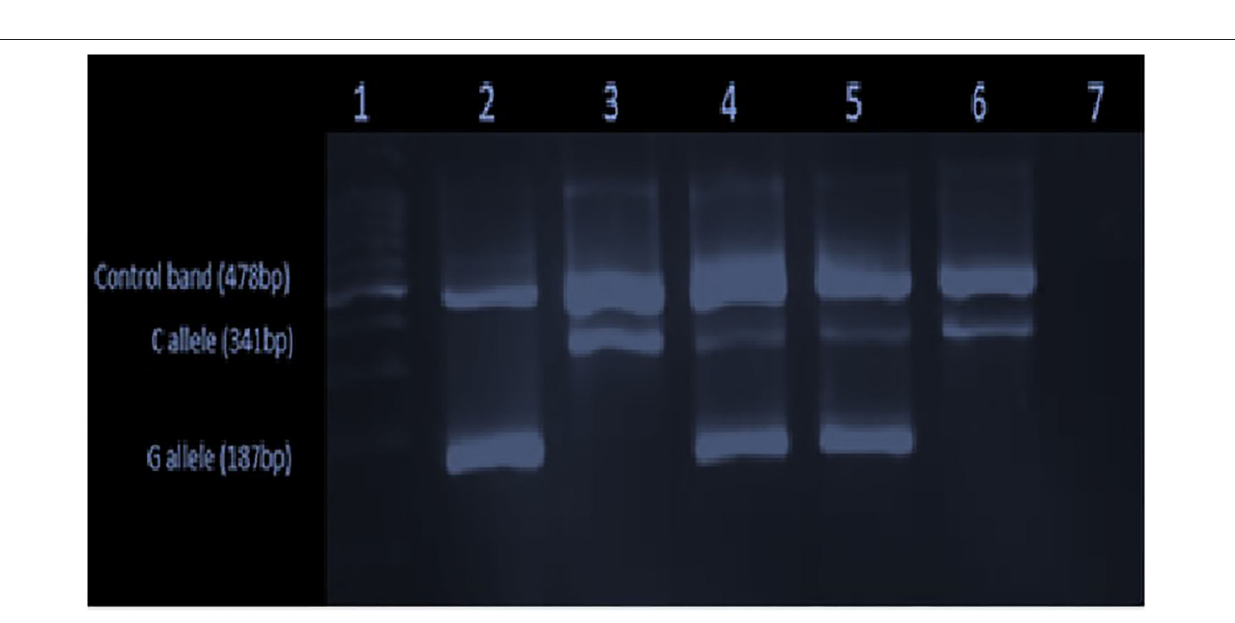
FIGURE 2 | Gel image showing the p.H63D [c.187C > G] mutation: 100 bp ladder in the 1st lane, homozygote for mutant G allele (GG) in the 2nd lane, the homozygote for wild type (CC) in the 3rd lane, heterozygous for the mutant allele (CG) in the 4th lane and the positive control (CG) in the 5th and the negative control and the blank in the 6th and the 7th lanes,